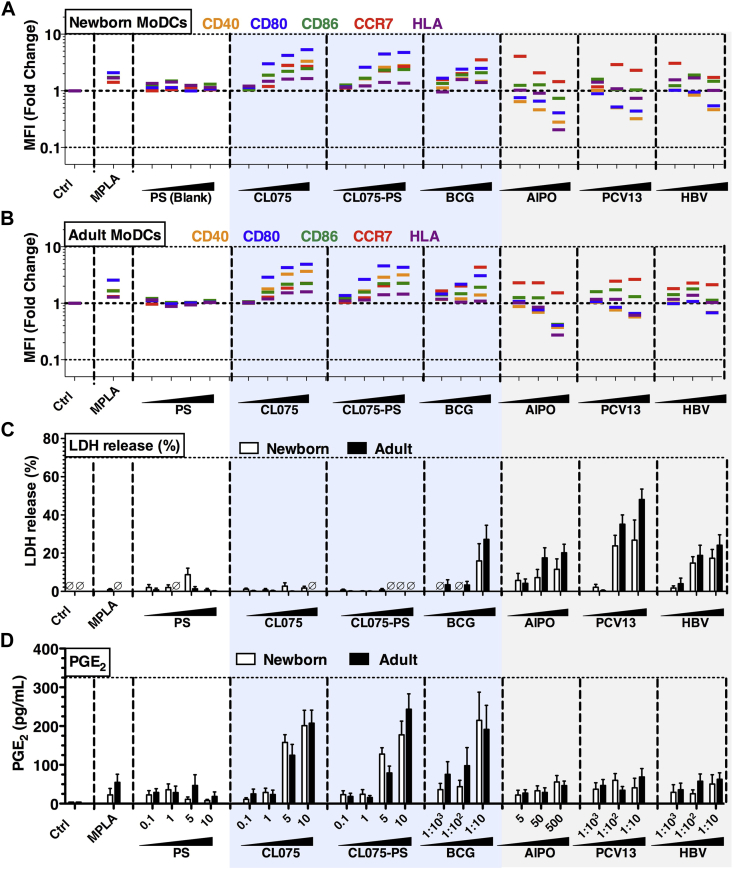
CL075-PS induces a robust MoDC activation profile similar to that of BCG and distinct from that of alum-adjuvanted subunit vaccines. A and B, Newborn (Fig 4, A) and adult (Fig 4, B) MoDCs were cultured in 10% (vol/vol) autologous plasma and stimulated for 24 hours with fixed concentrations of monophosphoryl lipid A (MPLA; 100 ng/mL), CL075, CL075-PS (both 0.1, 1, 5, and 10 μmol/L), alum (5, 50, and 500 μg/mL), BCG, PCV13, or HBV (each at 1:1000, 1:100, and 1:10 vol/vol). Surface expression of costimulatory molecules and HLA was determined by using flow cytometry and analyzed as fold change in mean fluorescent intensity (MFI) versus vehicle control (mean ± SEM, n = 5-8). C, Neither polymersomes (PS), CL075, nor CL075-PS induced cell death. Undetectable LDH levels are indicated by a circle with a diagonal line through it. D, PGE2 production, as measured by means of ELISA, benchmarked to adjuvants and licensed pediatric vaccines (mean ± SEM, n = 6). See also Figs E7 and E8 and Table E1.